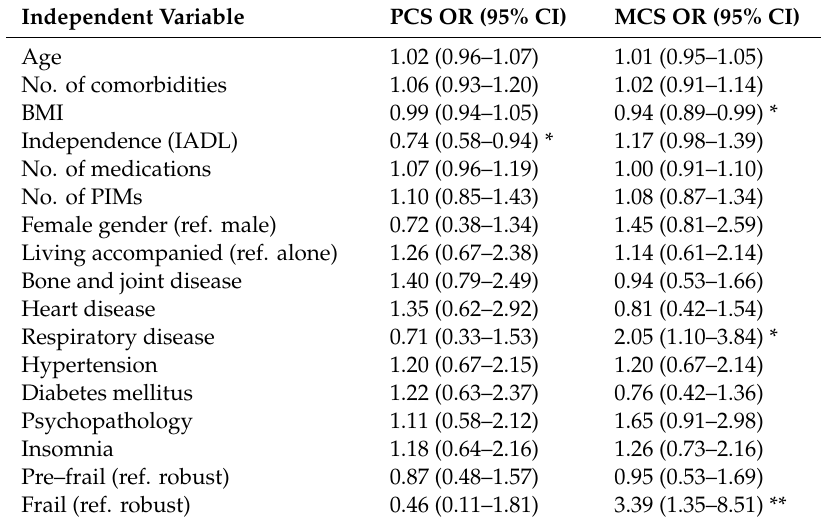
Table 3. Factors related to HRQoL. Multinomial logistic regression for High HRQoL (with respect to Very High HRQoL) for physical and mental health components (PCS-MCS).